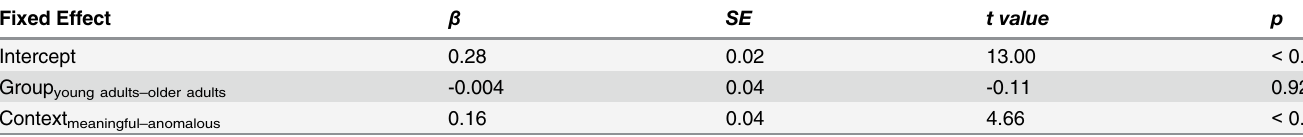
Table 5. Results of the effect of group and semantic context on relative visual benefit at -12